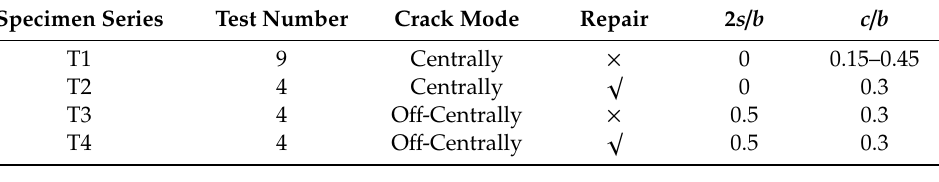
Figure 4. Test set-up and fracture mode. Figure 3. Analytical illustration of an off-centrally cracked strip. Table 1. Mechanical properties of test materials.